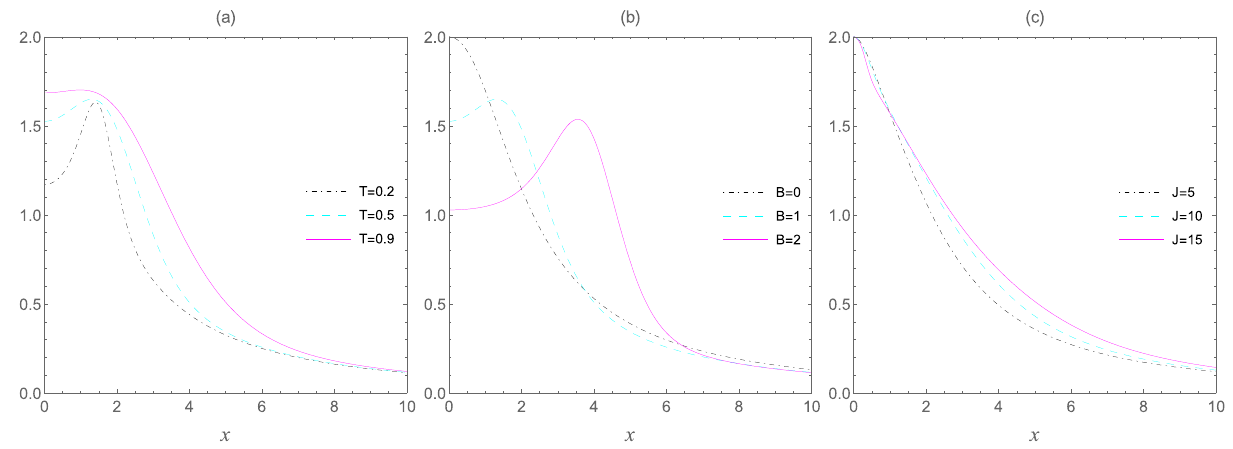
Figure 4. The entropic uncertainty bound U b (ρ T ,2 ) as a function of the inhomogeneity parameter x for fixed values of the temperature T , external magnetic field B , and the coupling constant J . Graph ( a ) B = 1; J = 1 , graph ( b ) T = 0.5 ; J = 1 , and graph ( c ) T = 0.5 ; B =